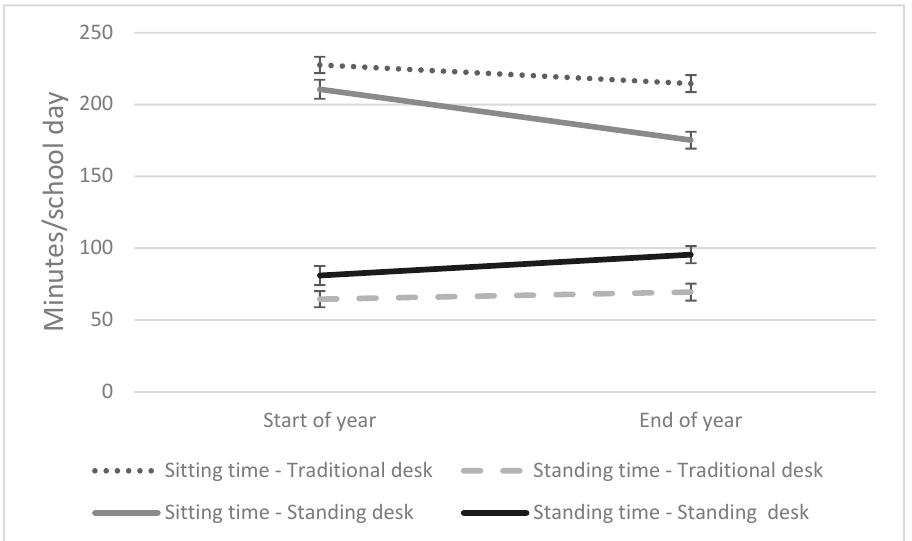
Figure 2. Sitting and standing time at the start and the end of the school year when using a standing desk and a traditional seated desk (min/school day (SE)).